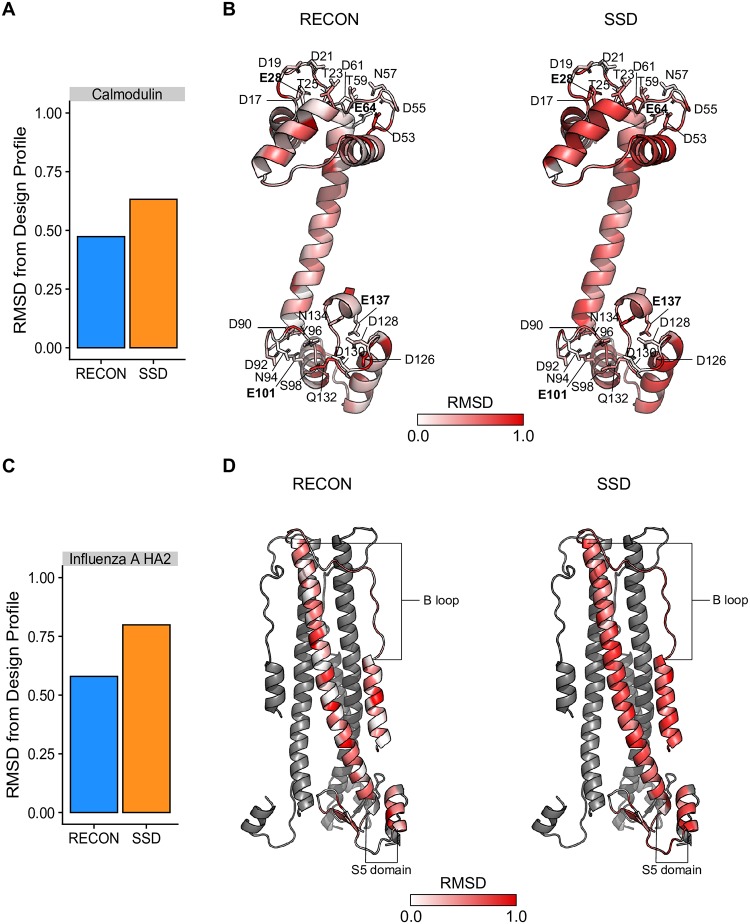
Comparison of mutation profiles predicted by protein design to mutation profiles observed within calmodulin and influenza type A HA2 multiple sequence alignments.(A) Comparison of root mean square deviation of mutation frequencies derived from calmodulin natural homologues to mutation profiles predicted by RECON MSD or SSD. Calmodulin natural homologue mutation preferences were derived from the multiple sequence alignment of calmodulin homologues. The root mean square deviation (RMSD) here represents the mean standard deviation of an individual residue’s mutation profile, consisting as the mean sum of squared differences of all twenty amino acid frequencies as determined by the multiple sequence alignment of calmodulin homologue sequences in relation to either RECON MSD or SSD residue profile. (B) Residue profile standard deviations between calmodulin multiple sequence alignment profiles and design profiles mapped onto the unbound conformation of calmodulin (PDB ID 1CLL). Here, RMSD represents the mean sum of squared differences of all twenty amino acid frequencies of each residue between homologue and design profiles. Residues whose sequence profiles were predicted to have identical mutation profiles as that within the corresponding position with the multiple sequence alignment are colored in white. The greater the dissimilarity between the homologue mutation profile and design profile, the greater the saturation in red, with complete saturation indicating an RMSD of 1.0. Residues within all four of the conserved EF-hand motifs are labeled, with the bidentate ligand at position 12 critical for Ca2+ binding labeled in boldface. (C) Comparison of root mean square deviation of mutation frequencies derived from influenza type A sequence alignments to mutation profiles predicted by RECON MSD or SSD. RMSD is calculated in a similar fashion as in Panel A. (D) Residue profile standard deviations between HA2 multiple sequence alignment profiles and design profiles mapped onto the pre-fusion conformation of the HA2 trimer (PDB ID 2HMG). RMSD is calculated and labeled the same as in Panel B, but only one HA2 monomer is labeled with RMSD values of the influenza A IVR residue profiles in relation to RECON MSD or SSD profiles. The N- and C-terminal residues of loop regions that undergo large local conformational rearrangements in the post-fusion form are labeled. This includes the B loop that rearranges into an alpha helix and the S5 domain, which stabilizes the alpha helical form of the B loop. Residues within the CR8020 broadly neutralizing epitope [32], including N146 and E150, are also labeled.